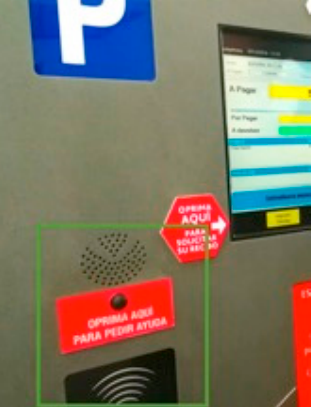
Figure 21. Interface of automated parking meter in commercial shopping center in Cali. The audio speaker is only useful for requesting assistance but does not work as a screen reader for the visually impaired.